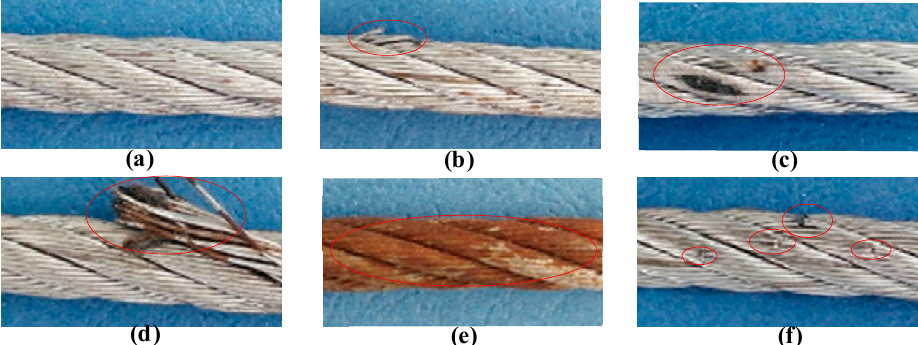
Figure 1. Sample pictures of wire rope damage. ( a ) Health; ( b ) wire breakage; ( c ) wear; ( d ) deformation (broken strand); ( e ) rust; and ( f ) fatigue (fatigue breaking). The description of different damage types of WRs is shown in Table 1. Table 1. Types and description of wire rope (WR) damage.